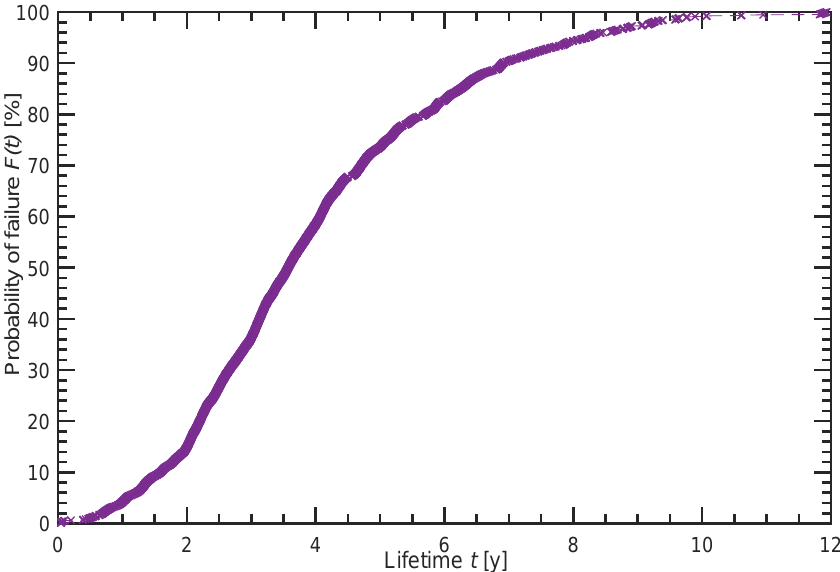
Figure 1. The total sample as a sum of all failures modes is shown in this graph for a time period of 12 years. On the left side the empirical probability of failure F(t) is shown